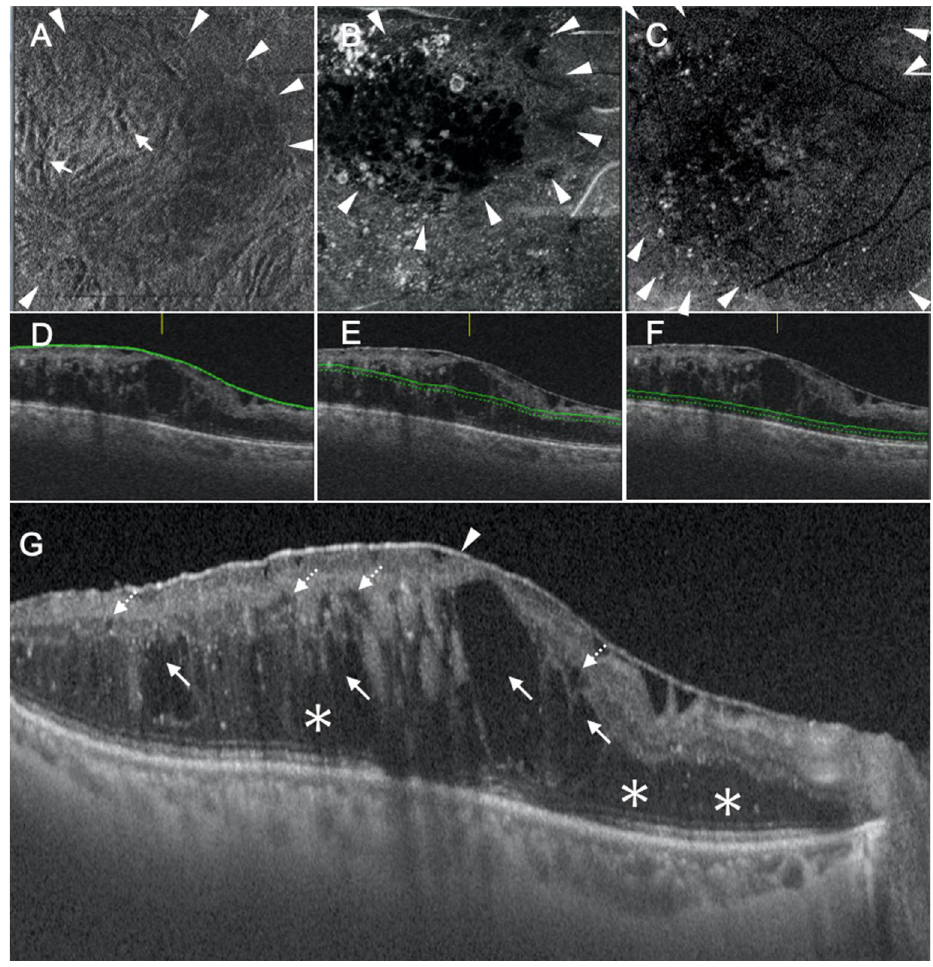
Figure 4. Representative case showing the diffuse fluid at Segment 1/diffuse fluid at Segment 2 type of diabetic macular edema. ( A – C ) En face images of the retinal surface ( A ), Segment 1 ( B ), and Segment 2 ( C ) are presented. Epiretinal membrane (ERM; arrowheads in A ) and associated retinal folds (arrows in A ) can be observed at the surface of the retina ( A ). There is diffuse fluid with an area larger than the parafoveal area at both Segments 1 and 2 (arrowheads in B , C ). ( D – F ) B-scan images and the green lines show the locations at which the en face images of the retinal surface ( D ), Segment 1 ( E ), and Segment 2 ( F ) were generated. The scan depth, indicated by the distance between the green line and green dotted line, was set to 0 μm for the en face image of the retinal surface ( D ) and 50 μm for the en face images of both Segments 1 and 2 ( E , F , respectively). ( G ) A horizontal B-scan image centered at the fovea is presented. The fluid at Segment 1 is located at both Henle’s fiber layer (arrows in G ) and the inner nuclear layer (dotted arrows in G ). There is diffuse fluid at Segment 2 (asterisks in G ). The arrowhead in ( G ) shows